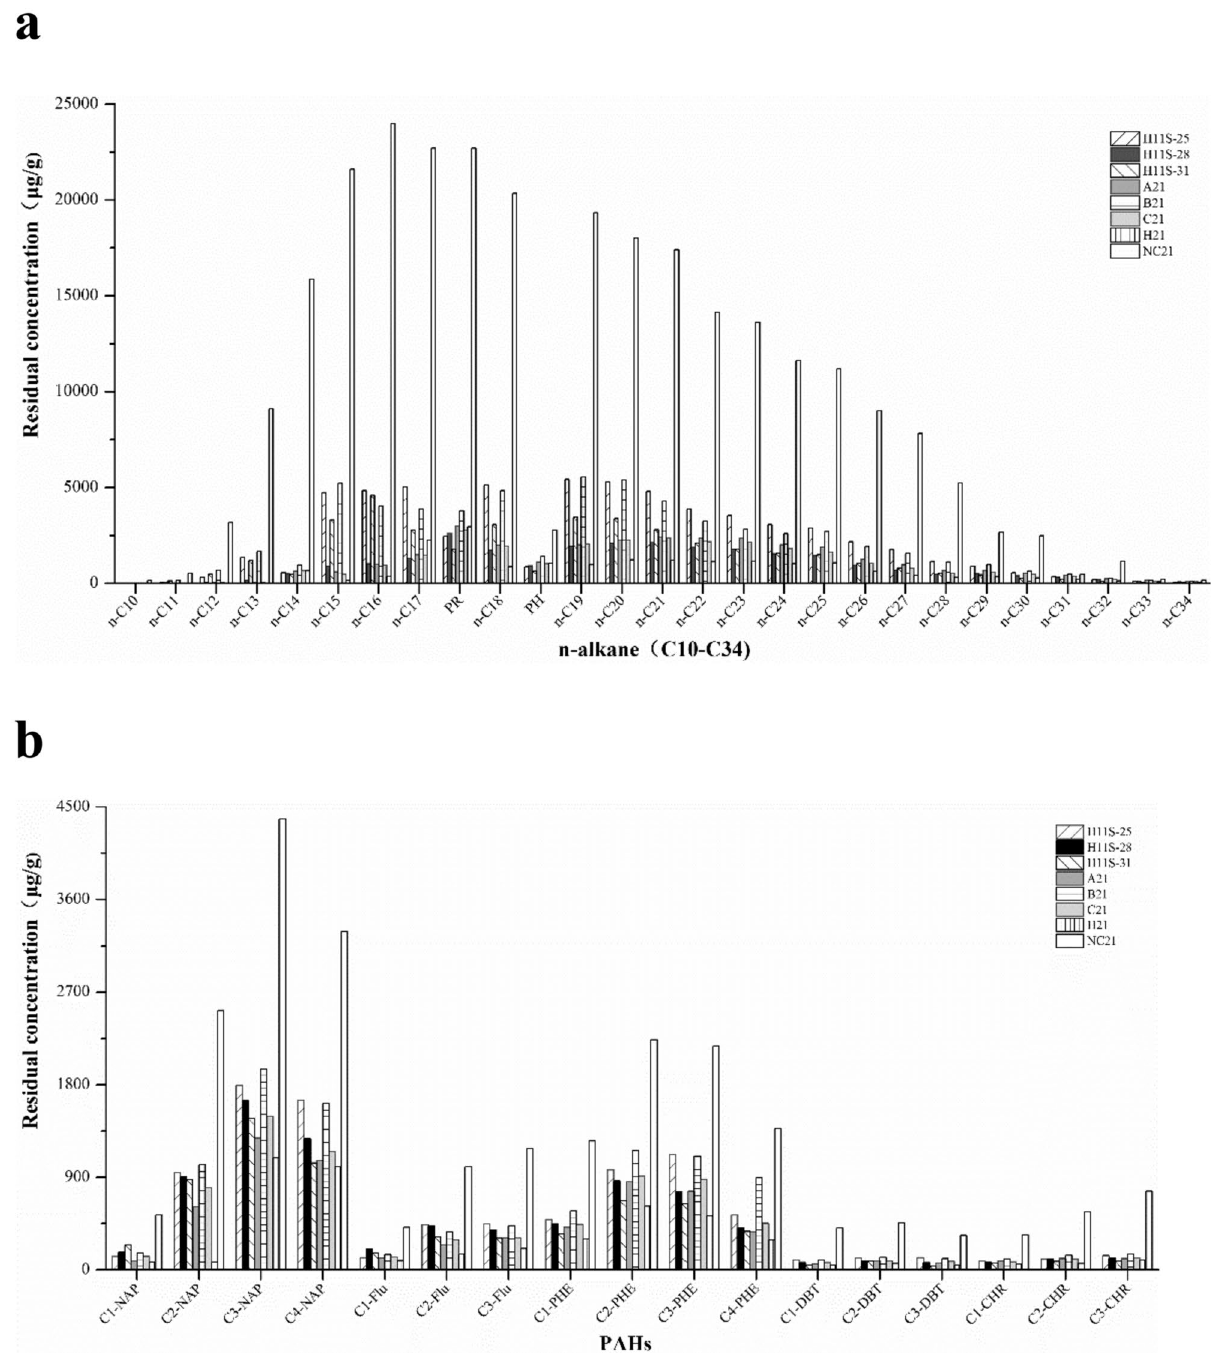
Figure 6. The n-alkanes and PAHs residual concentration in the crude oil after biodegrading 21 days by isolated strains and consortia ( a n-Cm: alkane with m carbon atom, for instance, n-C16 is alkane with 16 carbon atom; "PR" is pristane, "PH" is phytane. b NAP, FLU, DBT, PHE, and CHR represent for naphthalene, fluorine, dibenzothiophene, phenanthrene, chrysene, respectively. C1(C2, C3, C4)-NAP, alkylated naphthalene with straight-chain of 1 ~ 4 carbon atoms; C1(C2, C3)-FLU, alkylated fluorene with straight-chain of 1 ~ 3 carbon atoms; C1(C2, C3)-DBT, alkylated dibenantherene with straight-chain of 1 ~ 3 carbon atoms; C1(C2, C3, C4)- PHE, alkylated phenanthrene with straight-chain of 1 ~ 4 carbon atoms; C1(C2)-CHR, alkylated chrysene with straight-chain of 1 ~ 2 carbon